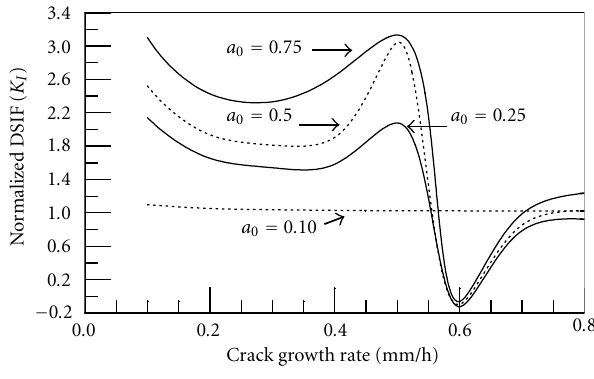
Figure 4.1. Variation of the normalized K I with the crack growth rate and initial crack